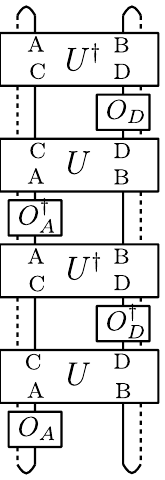
Figure 4 . Out-of-time ordered correlation (OTOC)